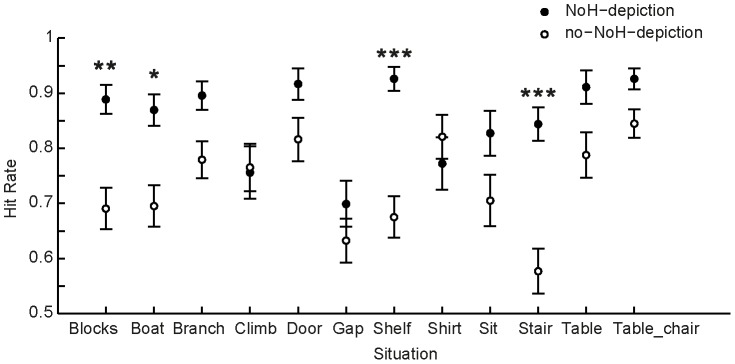
Interaction effect of NoH-depiction and situation on hit rates in P2-help.Filled black dots represent hit rates for NoH-depictions, hollow dots for no-NoH-depictions. Error bars represent SEM. Situations for which no-NoH/NoH-depictions were significantly different within the situation are marked with asterisks (*p<.05, ***p<.001, referring to post-hoc Tukey HSD tests). Also note that the main effect of NoH-depiction nonetheless shows that NoH-depictions are generally recognized better.